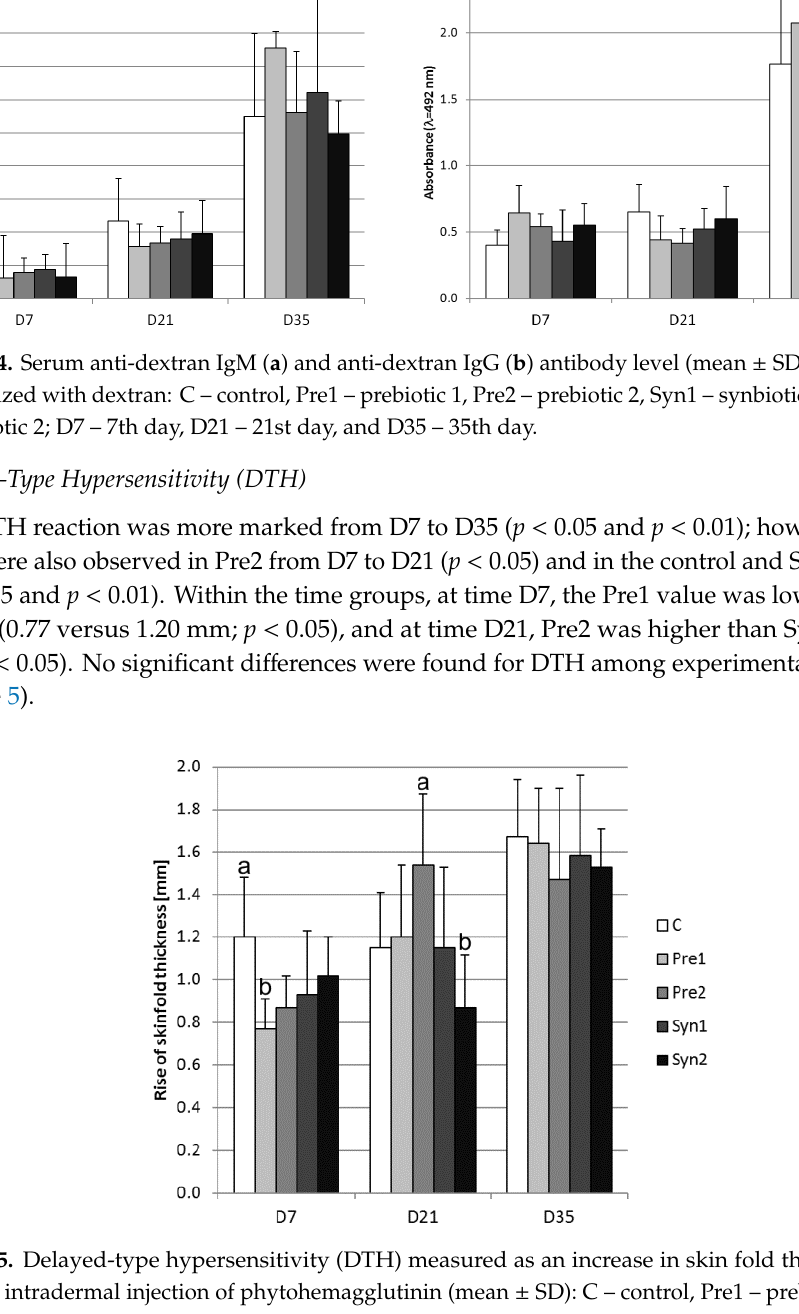
Figure 3. Serum reverse agglutination titer (mean ± SD) against SRBC: C – control, Pre1 – prebiotic 1, Pre2 – prebiotic 2, Syn1 – synbiotic 1, and Syn2 – synbiotic 2.